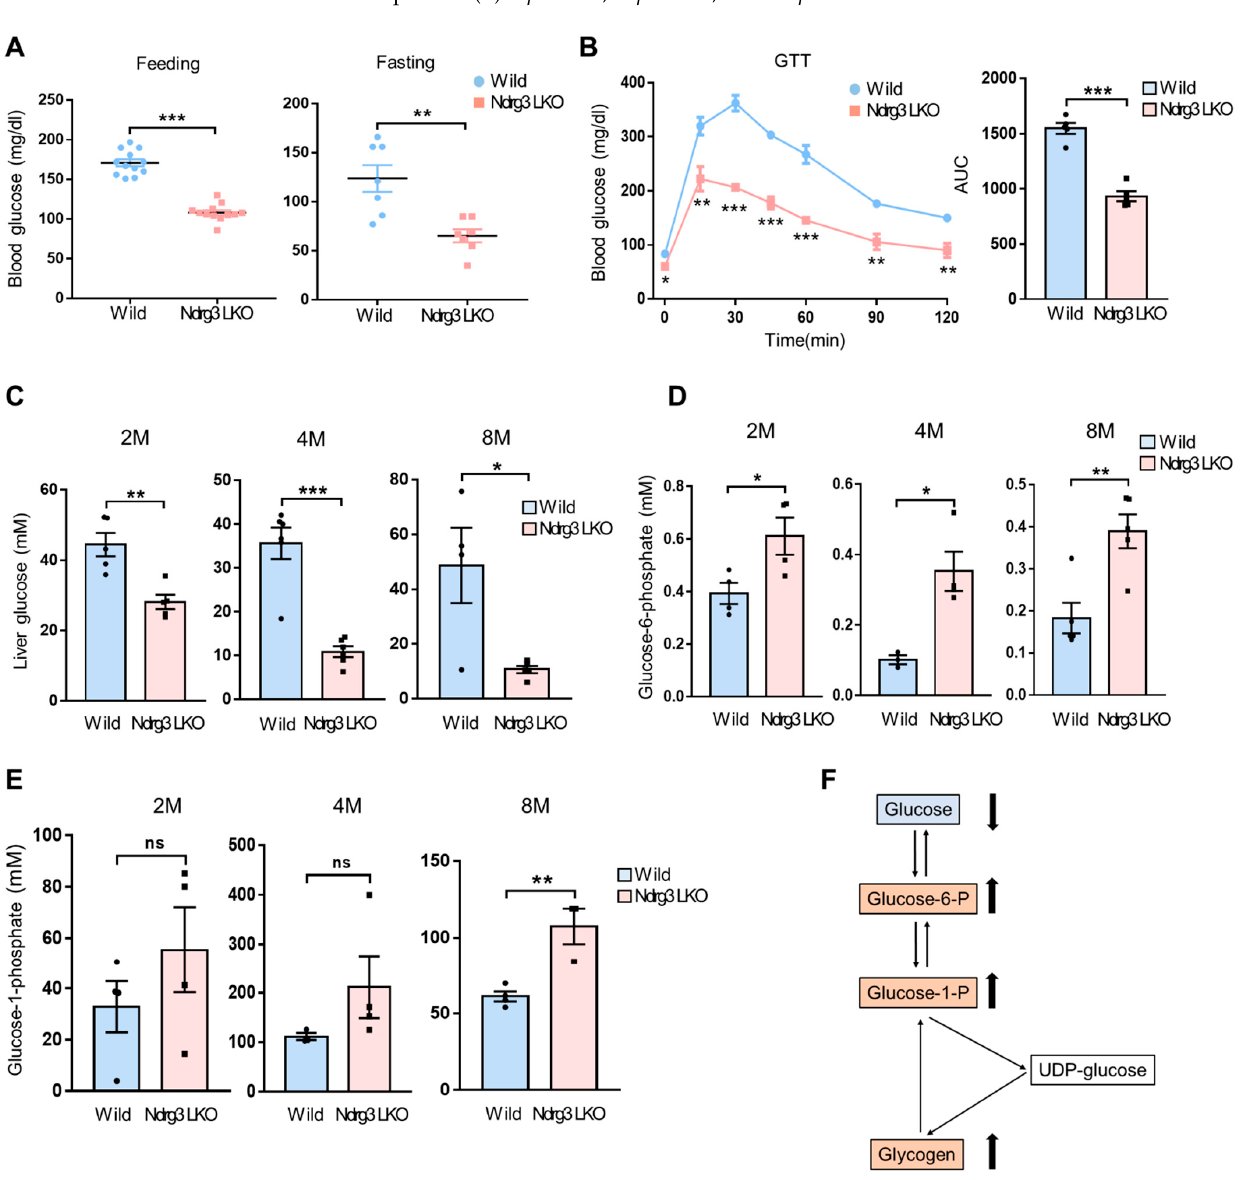
blood plasma of 2-month-old wild-type and Ndrg3 LKO mice ( n = 6 per group). ALT, alanine transaminase; AST, aspartate transaminase; ALP, alkaline phosphatase; T-bilirubin, total bilirubin; LDH, lactate dehydrogenase. ( D ) Periodic acid-Schiff (PAS) staining of liver tissues from overnight- fasted wild-type and Ndrg3 LKO mice. Scale bars; 100 µ m. ( E ) Quantification of hepatic glycogen volume in wild-type and Ndrg3 LKO mice at increasing ages. ( n = 3–5 per group). ( F ) Representative PAS staining images of primary hepatocytes isolated from the livers of 12-week-old male wild-type and Ndrg3 LKO mice. Scale bars; 200 µ m. Data are presented as mean ± SEM. p -values were calculated using two-tailed Student’s t -test ( A , C ), or two-way ANOVA with Tukey’s correction for multi-comparison ( E ). * p < 0.05, ** p < 0.01, and *** p < 0.001 vs. wild mice.